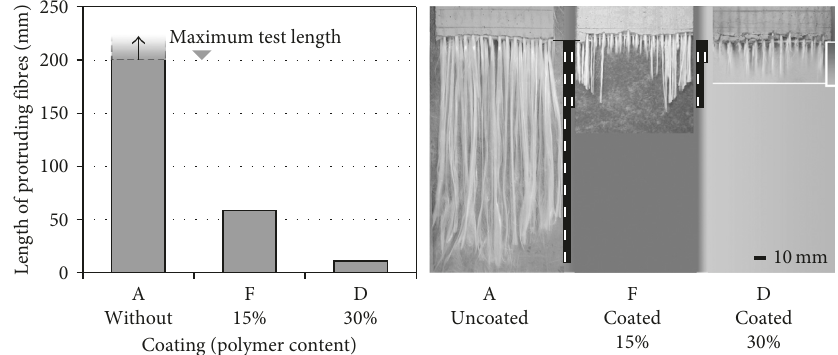
Figure 10: Effect of additional coating on the textile’s development length.